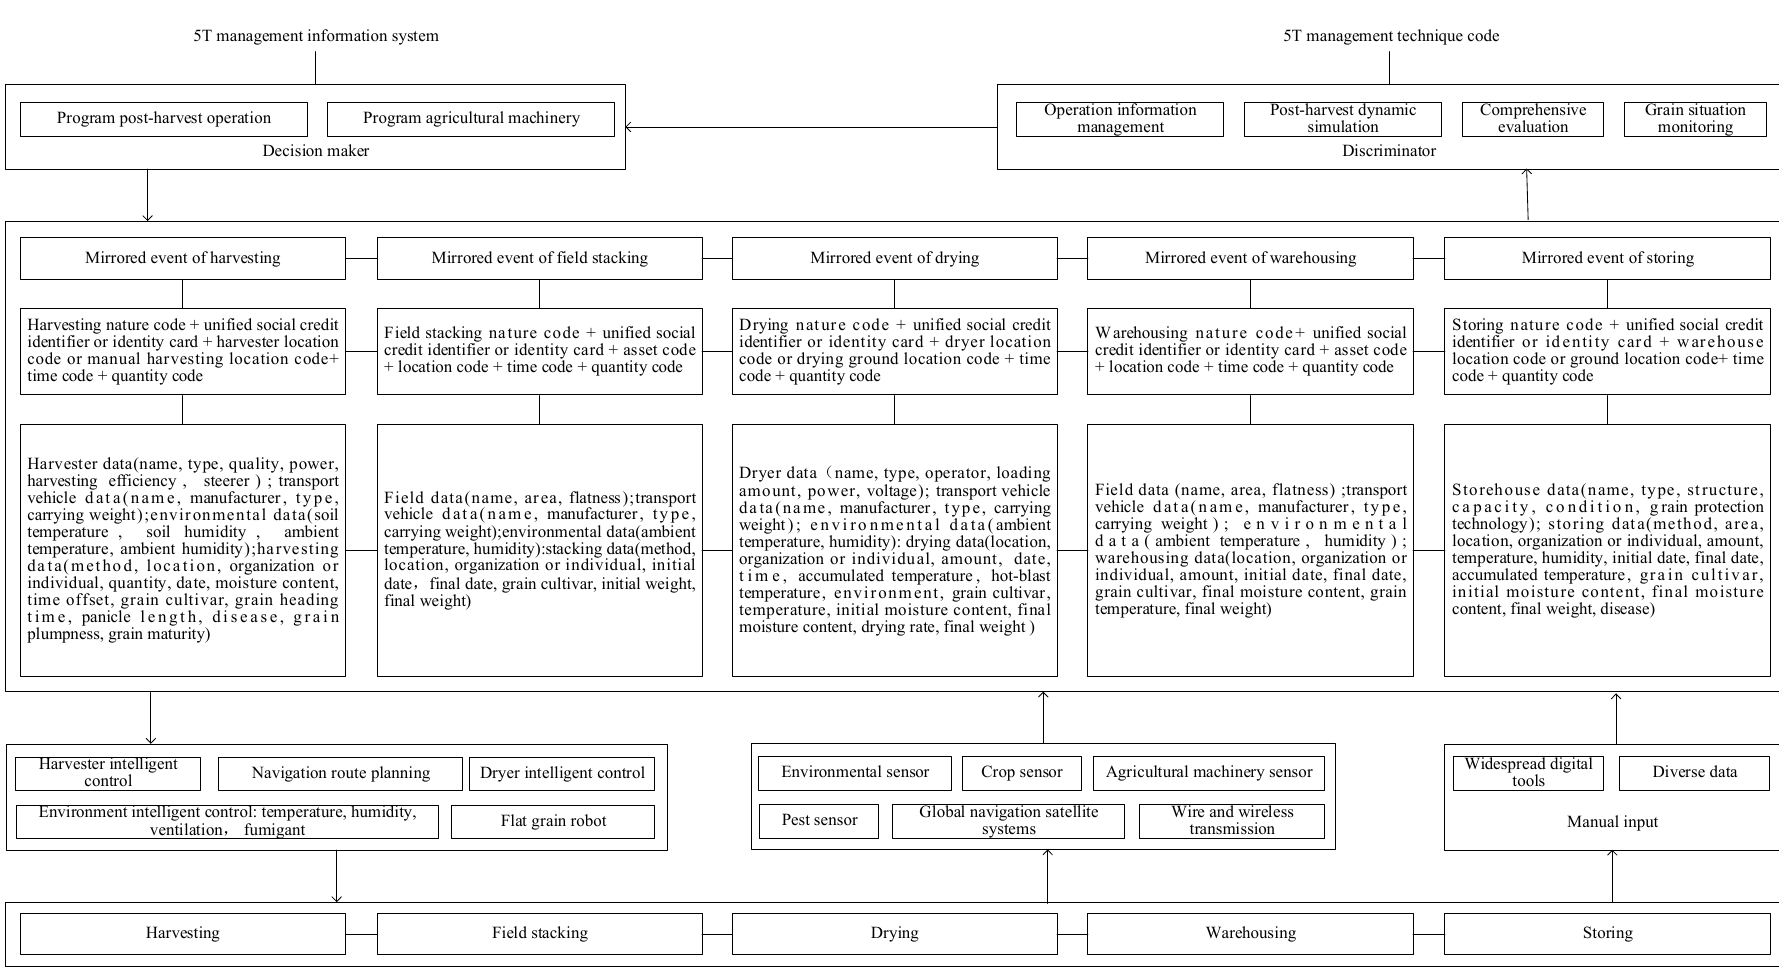
Figure 9. Grain period 5T management of the Shili Mirrored Structure.